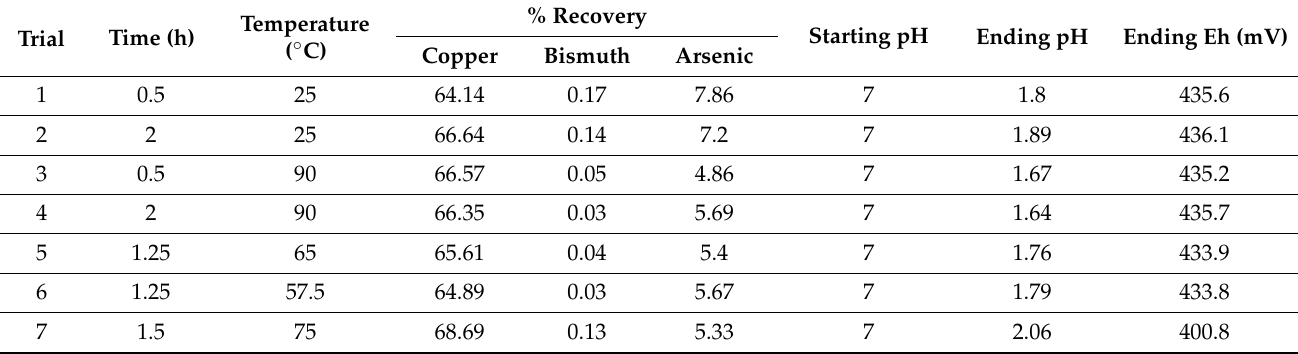
Table 12. Elemental recoveries (%) to leachates of water trials, pH data, and Eh data.